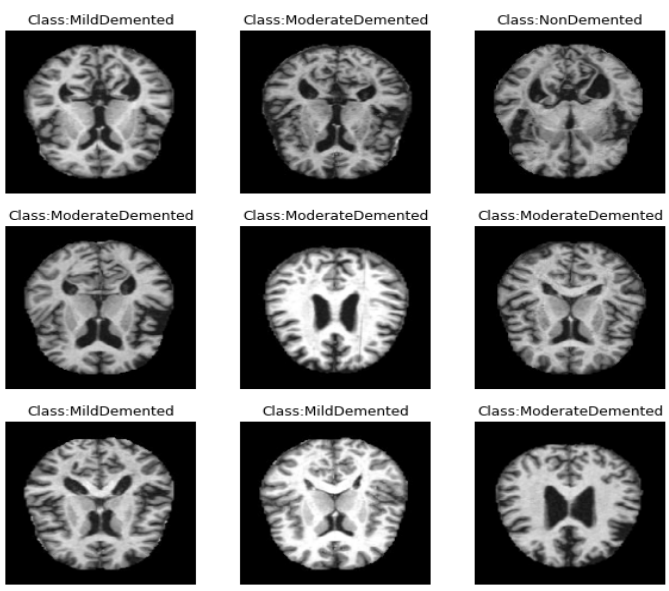
Figure 3. Train Images Sample.